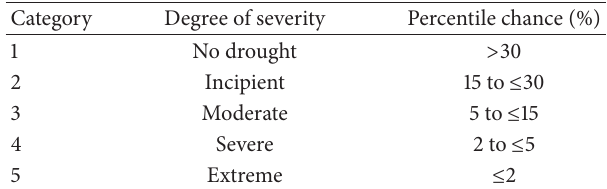
Table 1: Categories of the severity of drought as indicated by the 𝐾